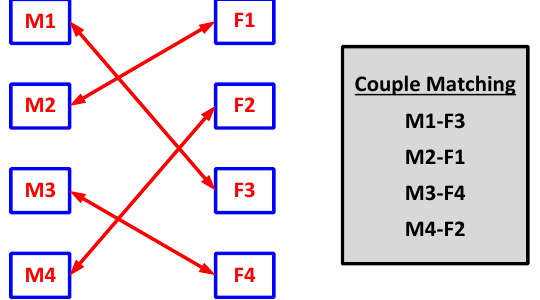
Figure 1. Male and female couple matching.